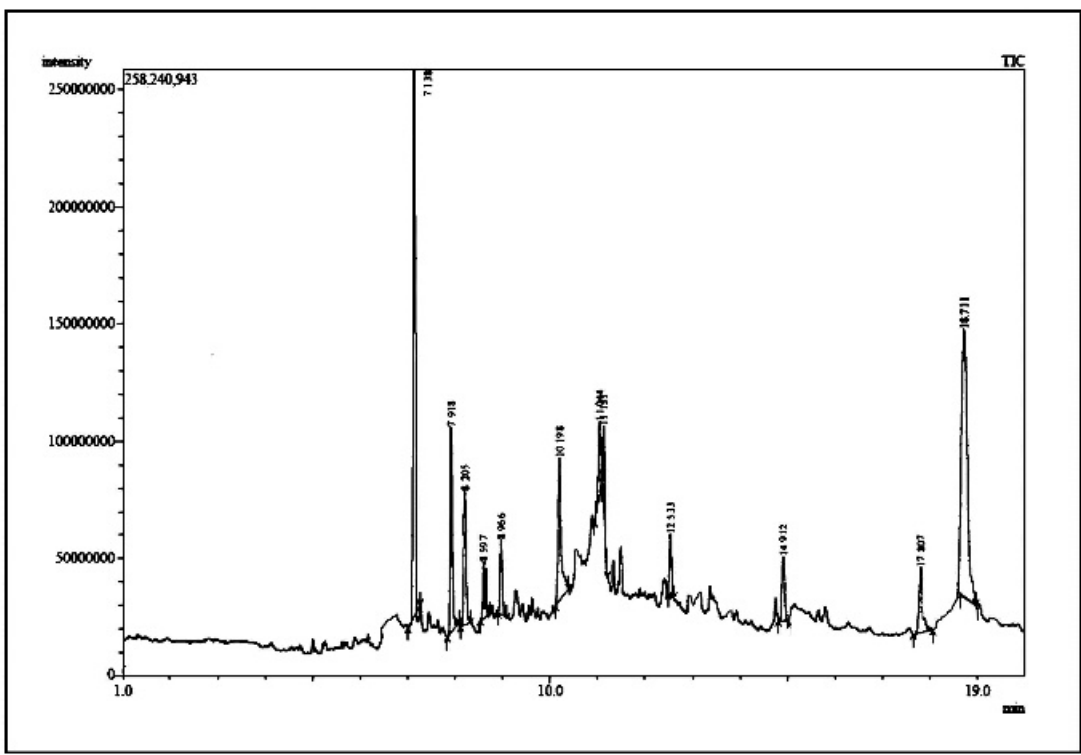
Figure 12. GC–MS chromatogram of E. sativa leaf extract.